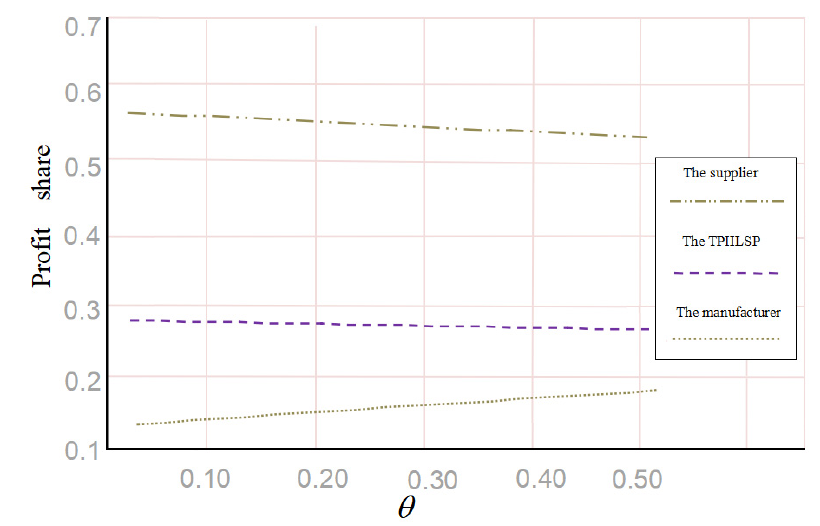
Figure 2. Impacts of θ on the proportions of the profits of all parties in the whole profit.